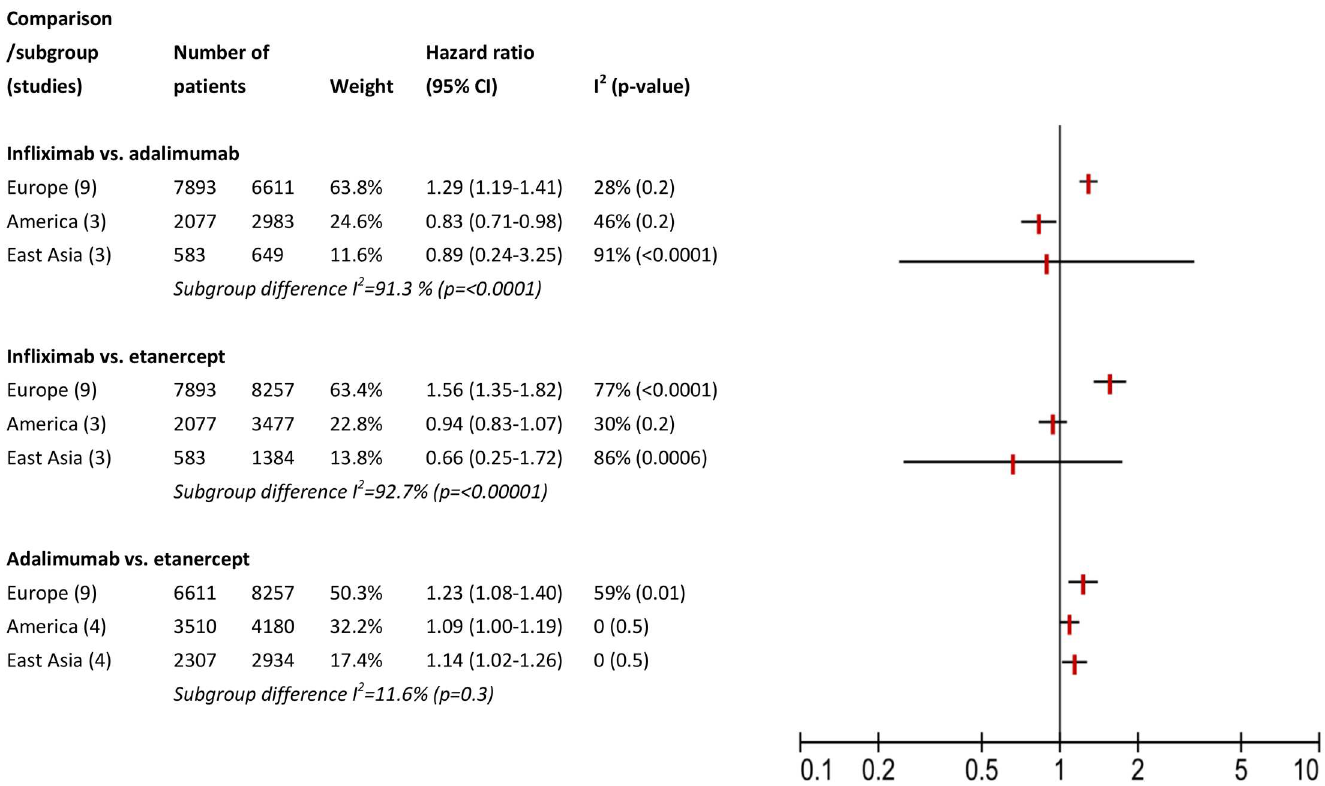
Fig 3. Assessment of clinical heterogeneity: subgroup analysis for